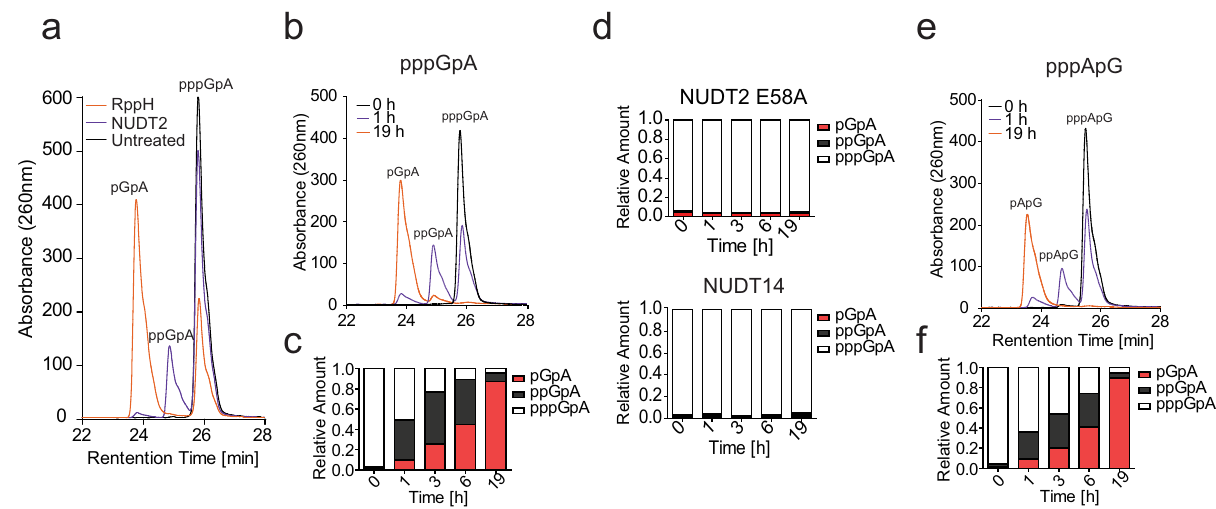
Fig. 4 NUDT2 sequentially releases phosphates from PPP-RNA. a A triphosphorylated RNA dinucleotide (pppGpA) was treated with NUDT2 (600 nM) or RppH (5 U) for 2 h at 37 °C. Additionally, the reference pppGpA was incubated in the same reaction buffer (untreated). Products were analyzed by reverse-phase HPLC. The absorbance at 260 nm at the indicated retention time is shown. b As ( a ) incubation with 600 nM NUDT2 for the indicated time. c As ( b ) but quanti fi cation of the generated RNA after incubation of pppGpA with NUDT2 for the indicated time. Quanti fi cation was performed by the integration of the corresponding peak area. d As ( b ) but incubation with NUDT2 E58A or NUDT14. e As ( b ), but the triphosphorylated dinucleotide pppApG was used as substrate. f As ( e ) but quanti fi cation of the generated RNA after incubation of pppApA with NUDT2 for the indicated time. Quanti fi cation was performed by the integration of the corresponding peak